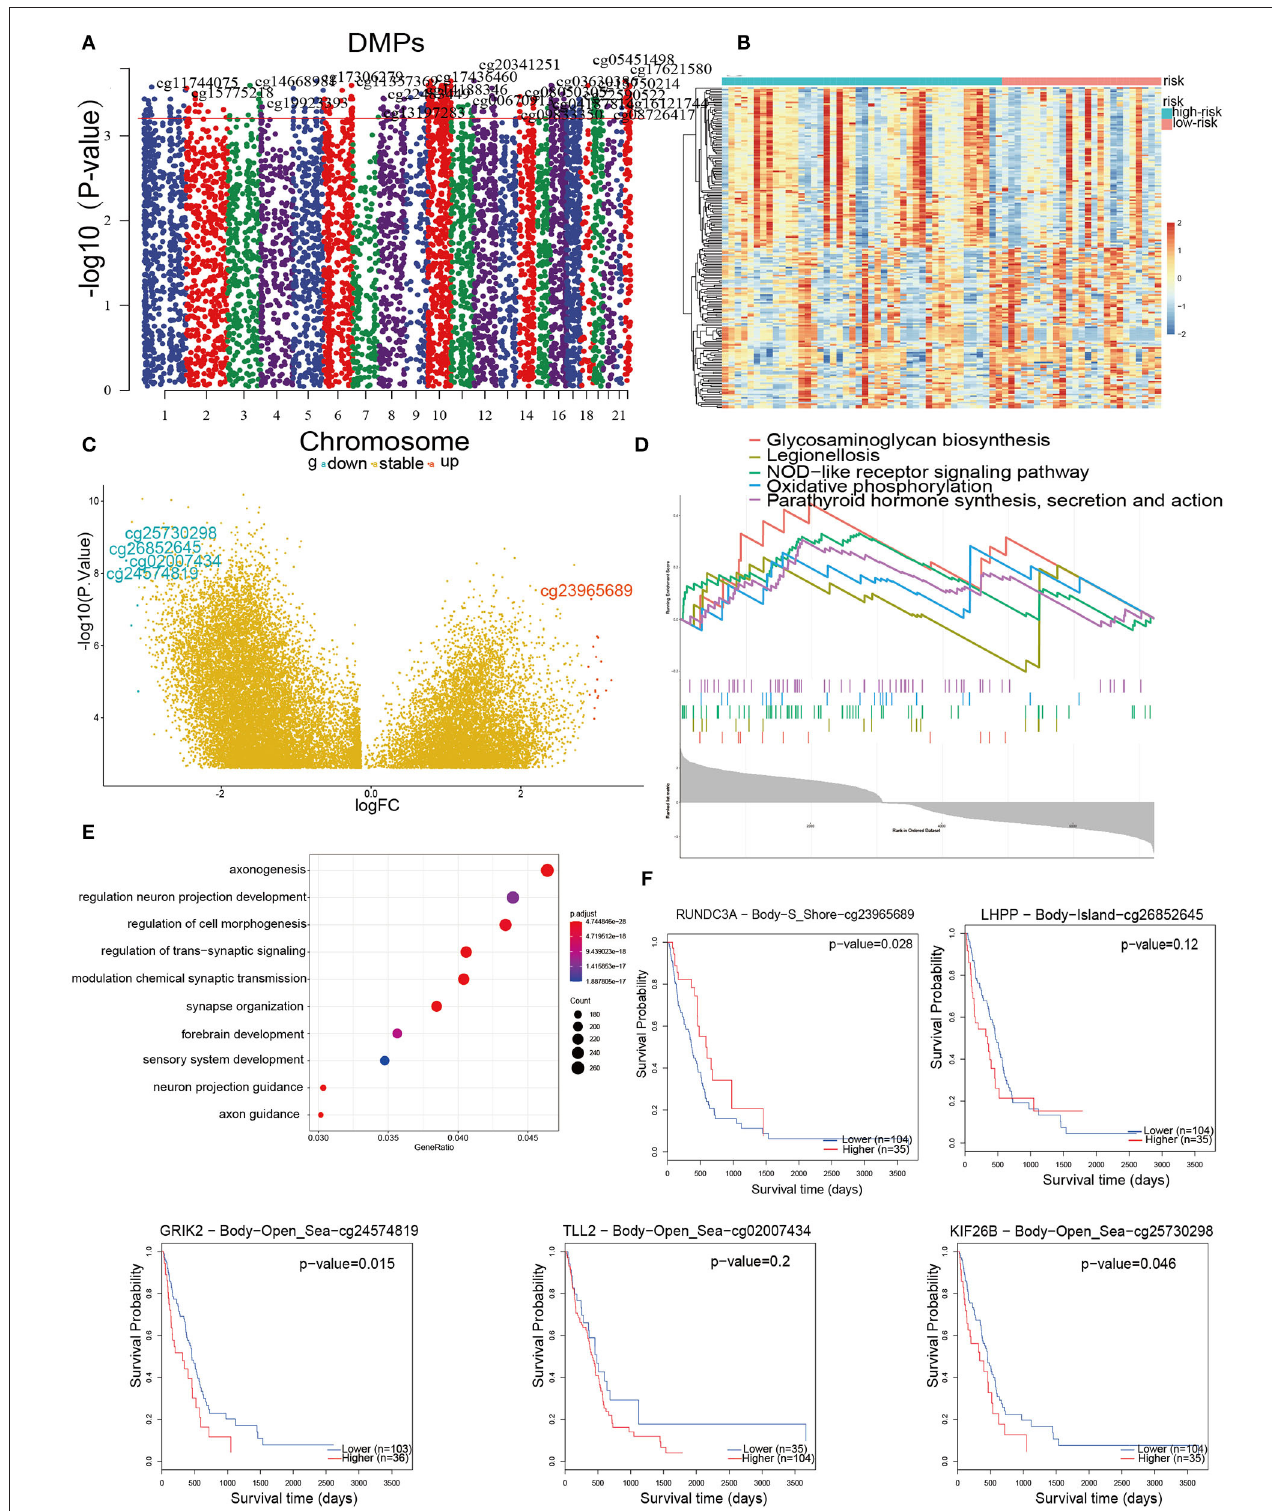
FIGURE 7 | DNA methylation pattern in high and low-risk groups. (A) Manhattan mapping of genome-wide DNA methylation differences in both groups. (B) Heatmap plot of the DMPs in two groups. (C) Volcano plot of DMPs based on both groups; Red illustrates downregulated genes, and blue illustrates upregulated genes. (D) GSEA showed considerable enrichment in five biological processes. Genes are listed by 1 beta. (E) GO enrichment analysis shows DEGs between both groups. Genes were ranked by 1 beta. (F) Kaplan-Meier curves of the five methylation sites with the largest fold difference.